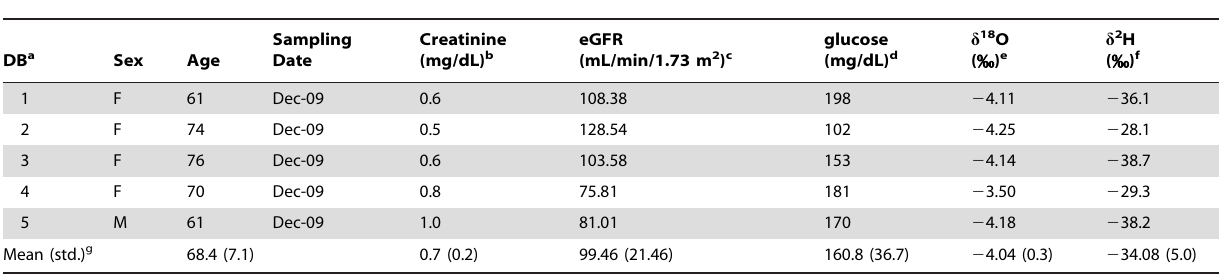
Table 3. Isotopic values of diabetes (DB) patient’s blood